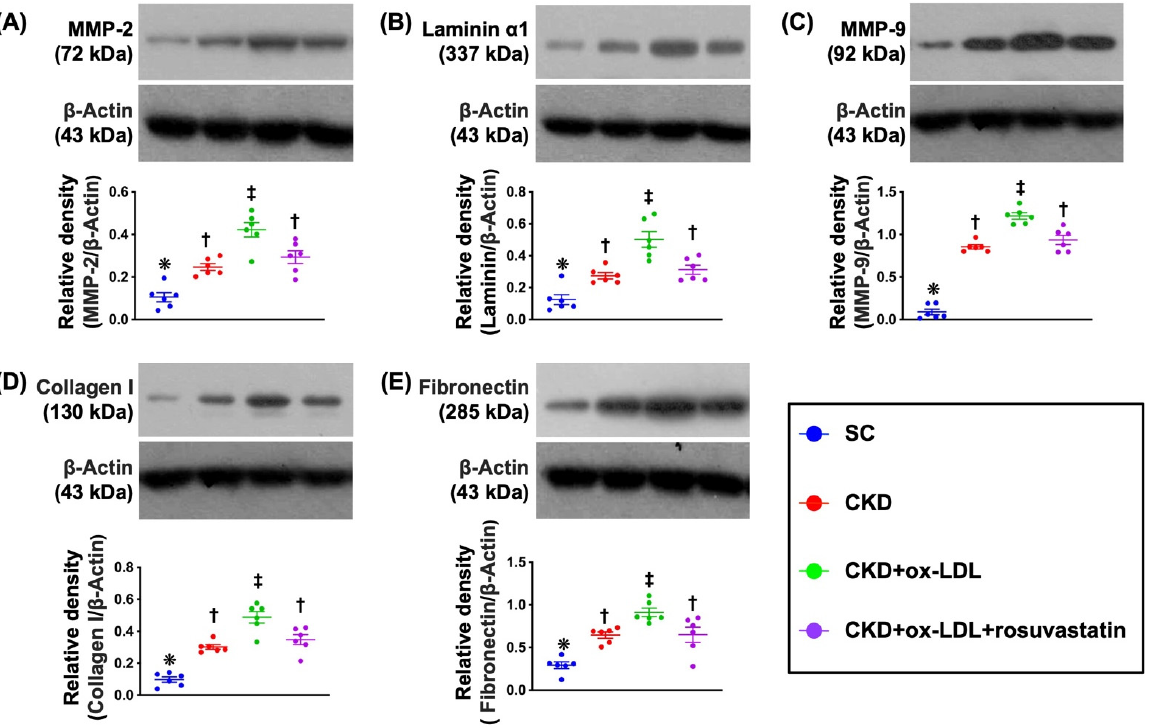
Figure 8. Protein expression of ECM in kidney parenchyma by day 42 after CKD induction. ( A ) Protein expression of matrix metalloproteinase (MMP)-2, * vs. other groups with different symbols (†, ‡), p < 0.0001. ( B ) Protein expression of MMP-9, * vs. other groups with different symbols (†, ‡), p < 0.0001. ( C ) Protein expression of laminin, * vs. other groups with different symbols (†, ‡), p < 0.0001. ( D ) Protein expression of fibronectin, * vs. other groups with different symbols (†, ‡), p < 0.0001. ( E ) Protein expression of collagen I, * vs. other groups with different symbols (†, ‡), p < 0.0001. All statistical analyses were performed by one-way ANOVA, followed by Bonferroni multiple comparison post hoc test (n = 6 for each group). Symbols (*, †, ‡) indicate significance for each other (at 0.05